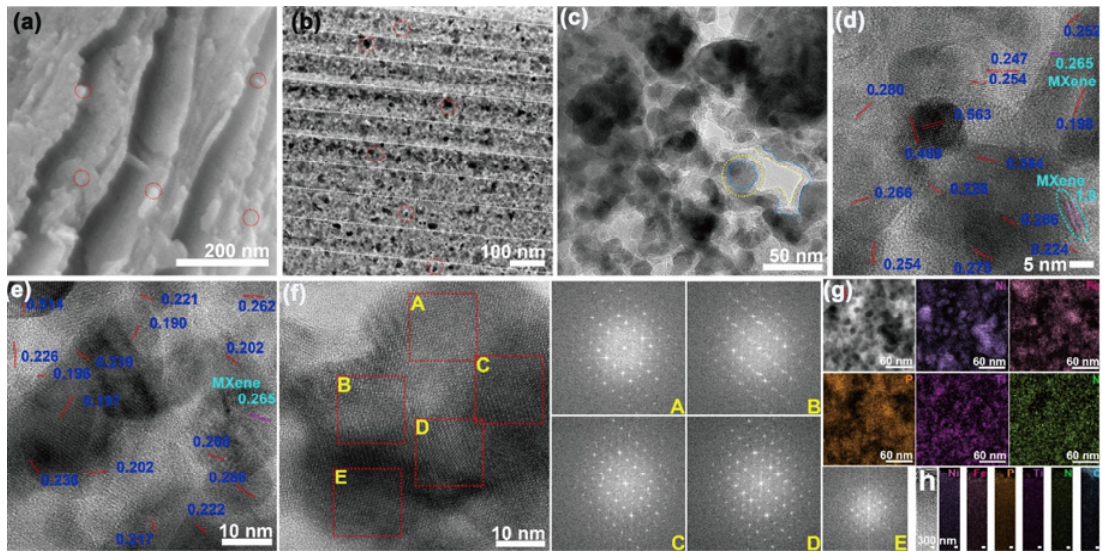
Fig. 3 (a) SEM, (b, c) TEM, (d, e) HRTEM images, (f) HRTEM images and corresponding FFT patterns, and (g, h) EDS elemental mappings of MXene/NiFeP x –NC